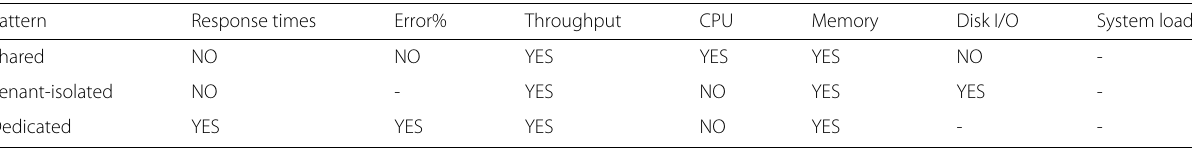
Table 3 Paired sample test analysis for case study 1